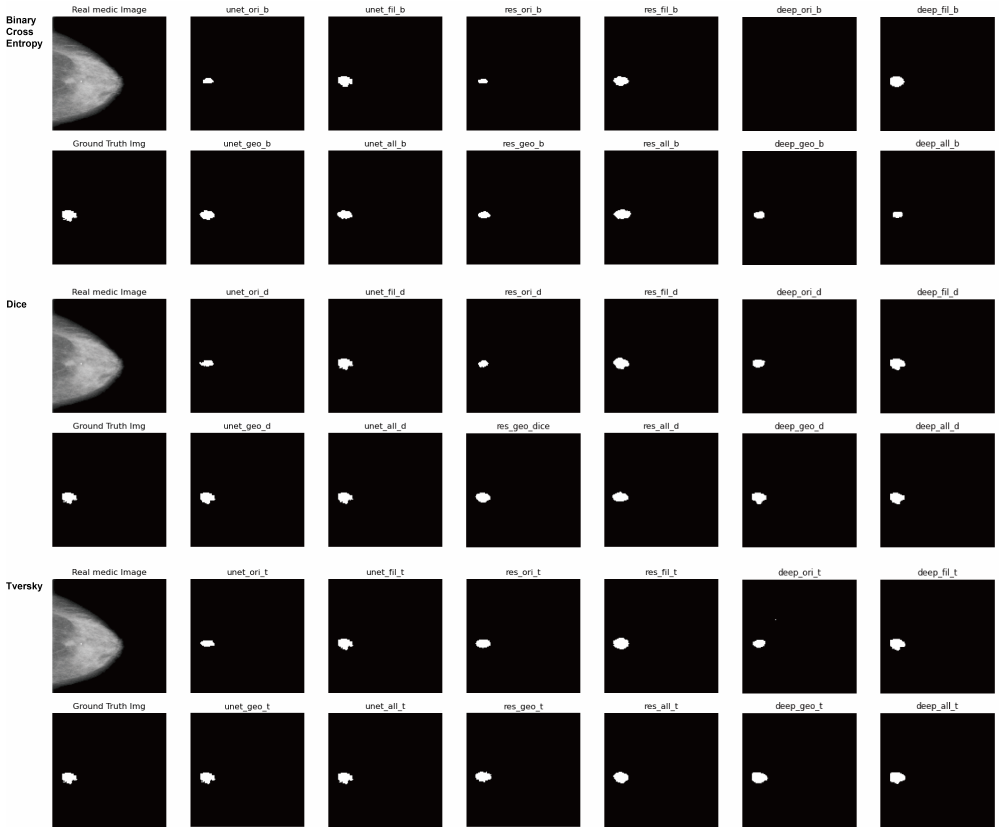
Figure 7. Result images for all combinations of the loss functions and the neural networks and the augmentation techniques in X-ray